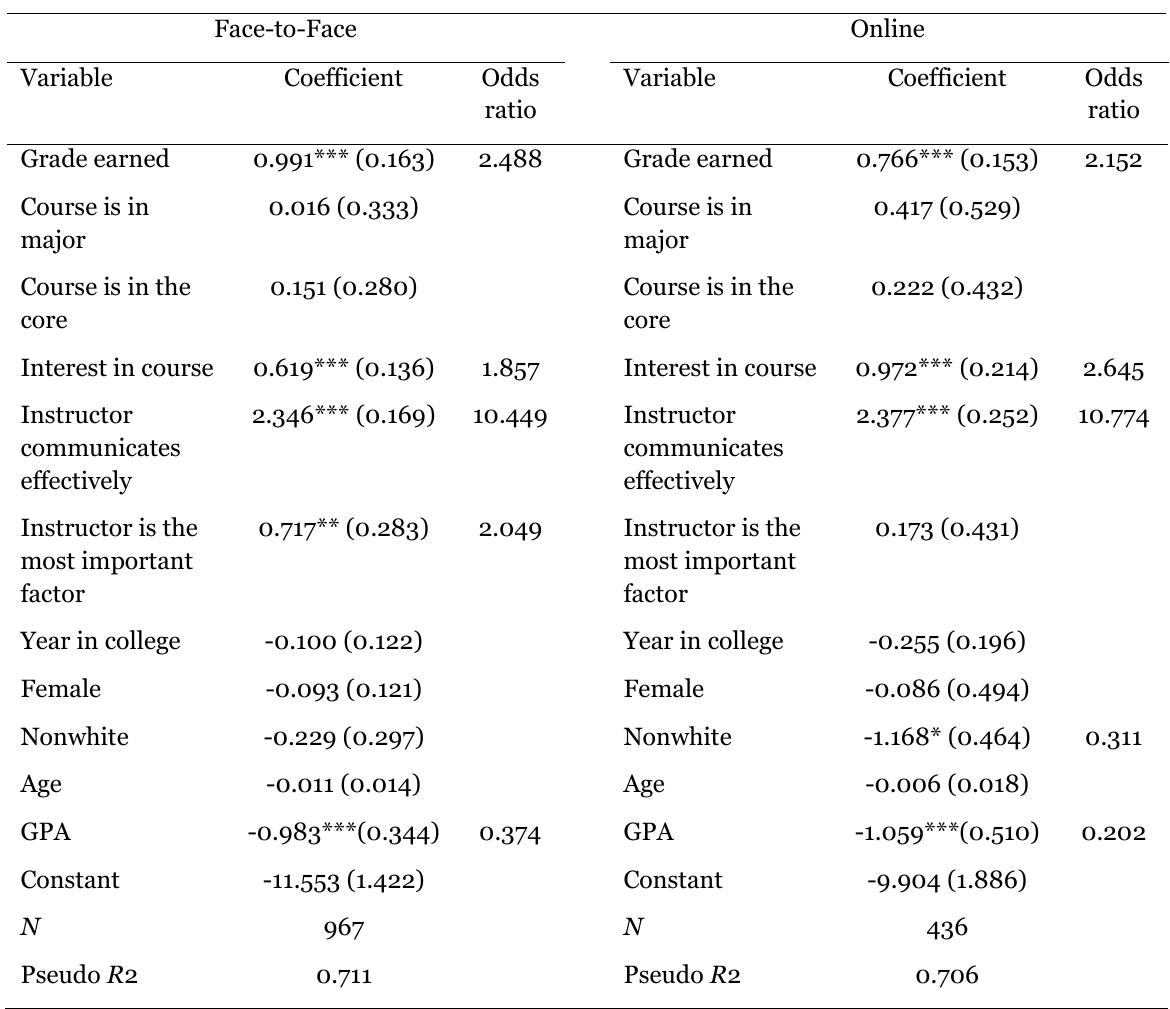
Table A3 Logit Models of Best Class Designation by Course